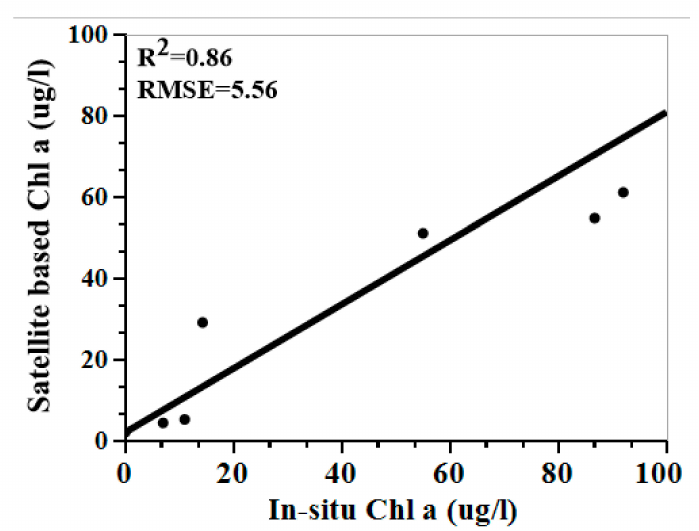
Figure 6. Satellite chlorophyll-a estimates comparisons against in-situ